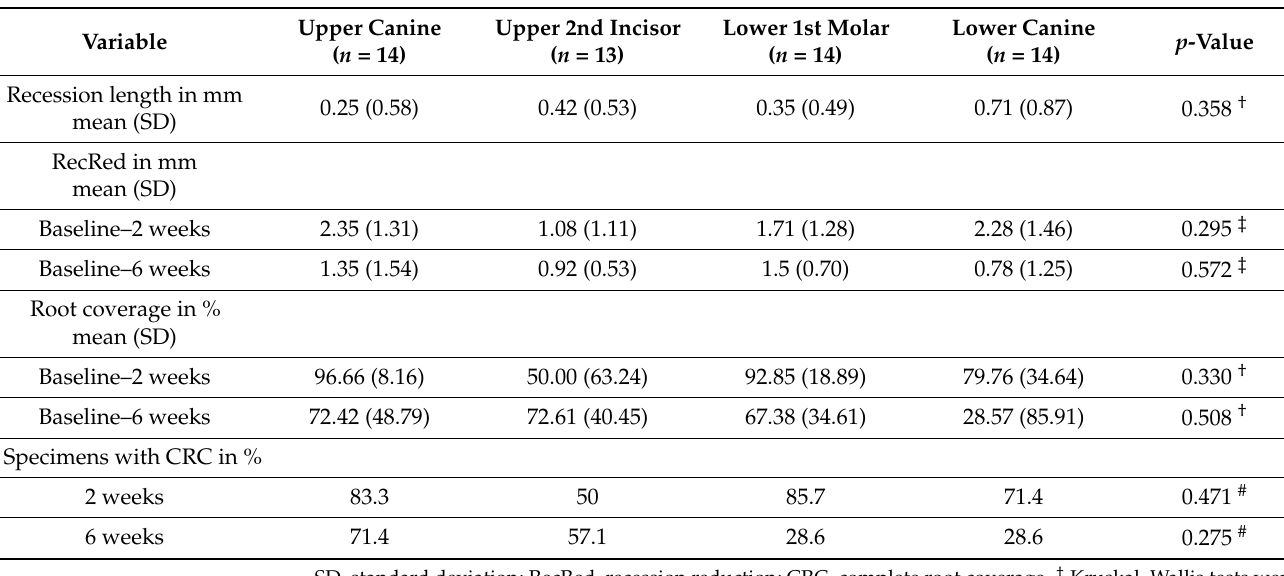
Table A3. Clinical Variables According to Tooth